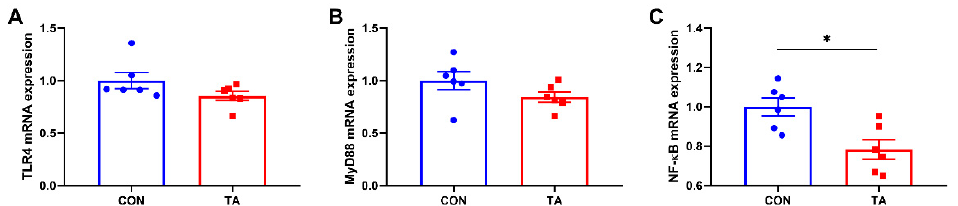
Figure 7. Effects of tannic acid extracted from Galla chinensis supplementation on expressions of inflammatory pathway genes in intestinal mucosa of broiler chickens. ( A ) Toll-like receptor 4 (TLR4); ( B ) Myeloid differentiation primary response 88 (MyD88); ( C ) Nuclear factor-kappa B (NF- κ B). CON, broiler chickens fed basal diet; TA, broiler chickens fed basal diet supplemented with 300 mg/kg microencapsulated tannic acid extracted from Galla chinensis . Values are mean ± standard error ( n = 6). Differences between treatments were displayed by * p <